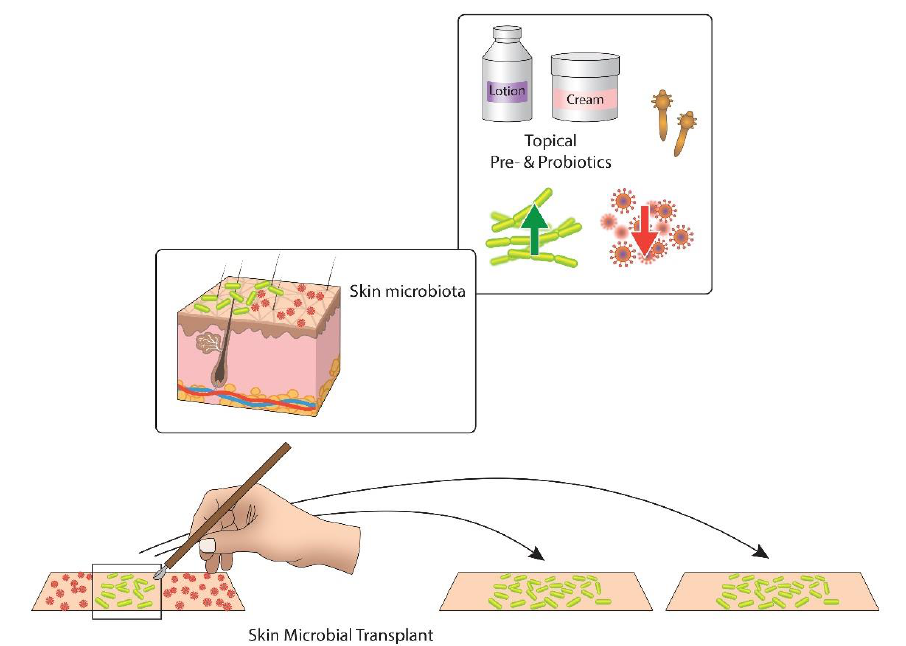
Figure 4. Two main approaches of controlling the human skin microbiota for the itch control. Topical pre- and probiotics target to increase the number of advantageous bacteria (green) and reduce pathogens (red). Skin microbial transplant is a new approach that transfers beneficial microbiota from healthy skin to itchy and dysbiotic skin [167] .